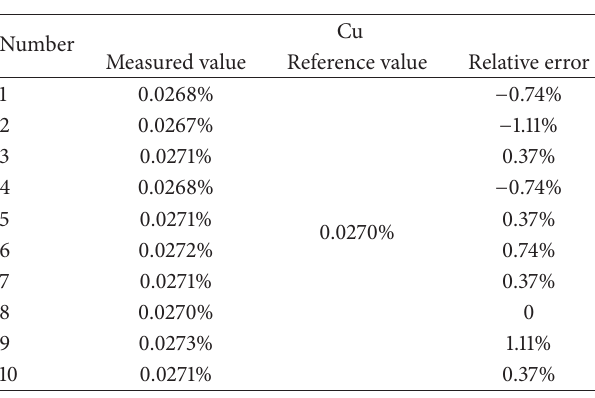
Table 6: Cu content of lead-based alloy.